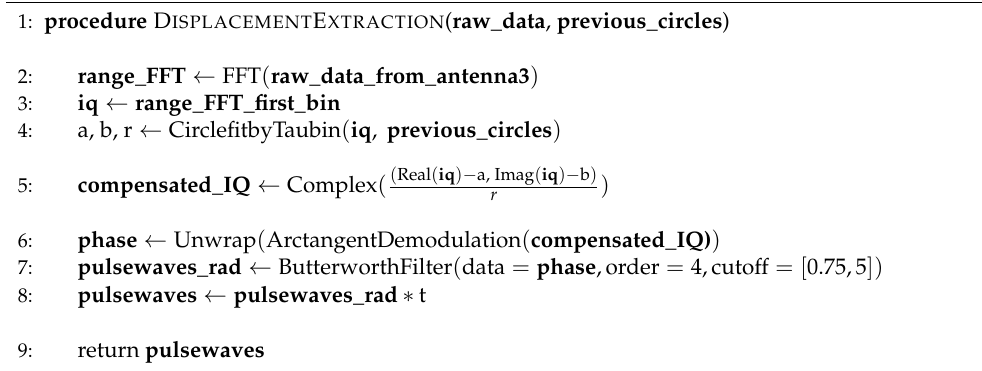
Algorithm 3 Pseudocode for displacement